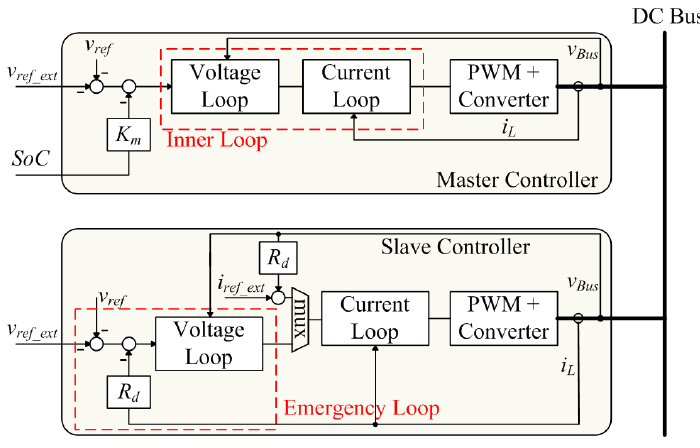
Figure 5. Local controller of the proposed method.